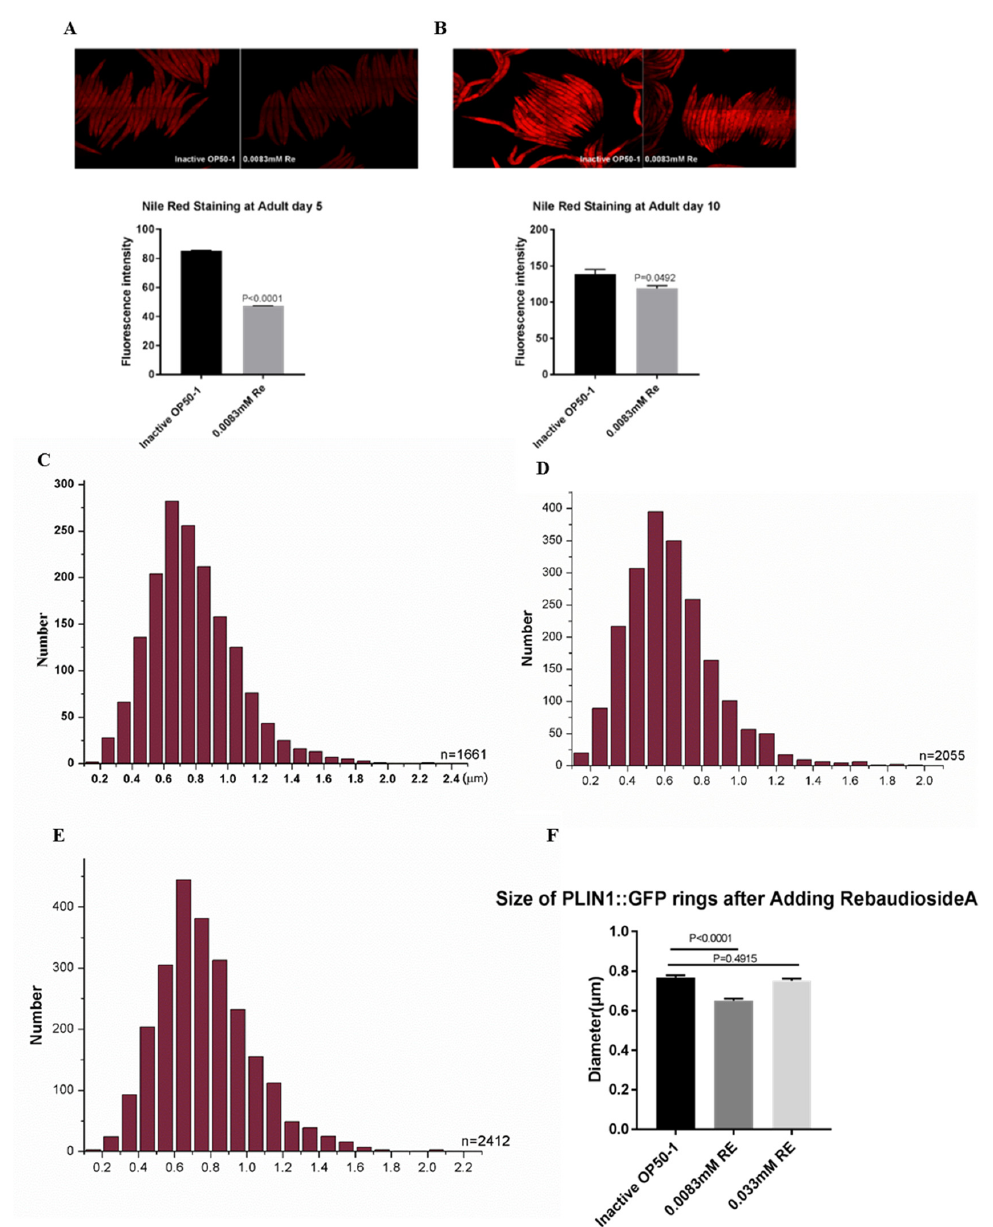
Figure 5. Reb A supplementation lowers lipid storage in C. elegans . ( A ) Nile red staining in 5-day-old adults from the 0.0083 mM Reb A and control groups; ( B ) Nile red staining in 10-day-old adults from the 0.0083 mM Reb A treatment and control groups. Statistical significance was calculated by unpaired two-tailed t test; ( C ) Distribution of lipid droplet diameters in 1st xdEx1001 strain in control group; ( D ) Distribution of lipid droplet diameter of 1st xdEx1001 strain in 0.0083 mM Reb A treatment group; ( E ) The adult lipid droplet diameter distribution of 1st xdEx1001 strain in 0.033 mM Reb A treatment group; ( F ) Quantification of the size of PLIN1:GFP rings in Reb A treatment groups relative to the control group. Statistical significance was calculated by ANOVA with post hoc Dunnet’s